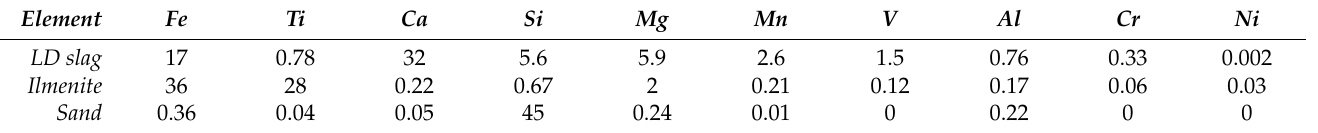
Table 1. Elemental composition is given in wt.% of the studied bed materials excluding oxygen.